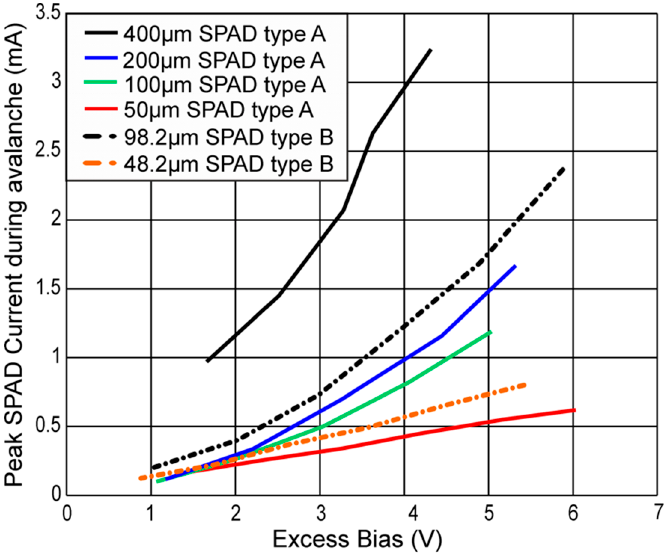
Figure 10. Peak avalanche-current for SPADs type A and B in dependence on the excess bias.